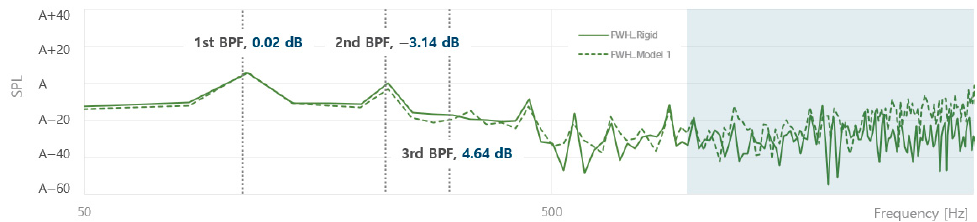
Figure 10. Sound pressure level of rigid and composite propellers (model 1) in a non-cavitating flow.